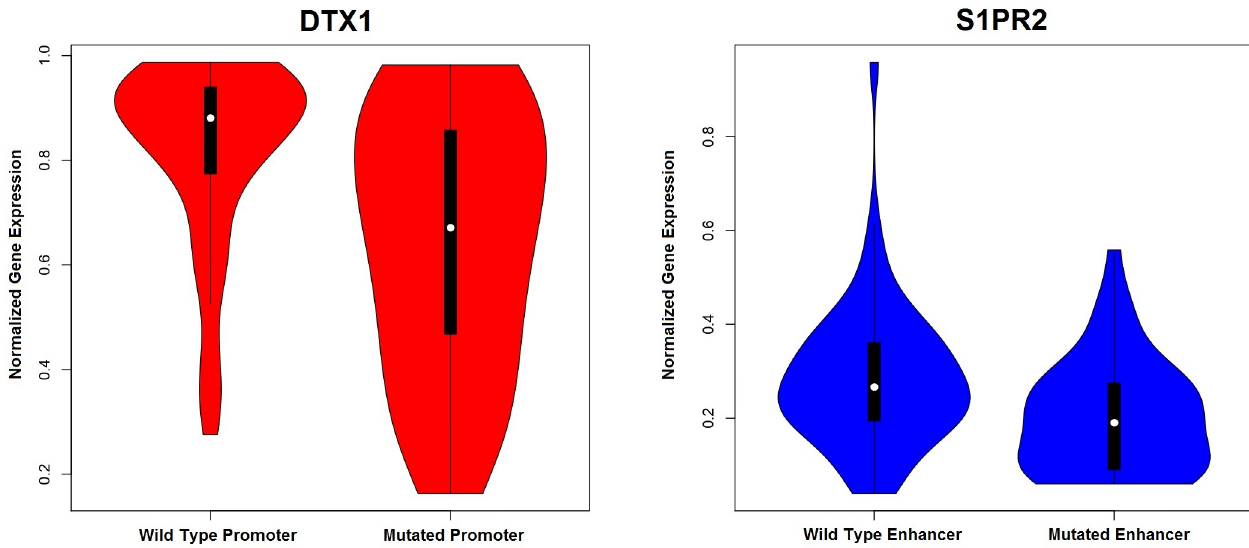
Fig 4. Violin plots representing the distribution of gene expression between mutated and unmutated DTX1 promoters (left image) and S1PR2 enhancers (right image).